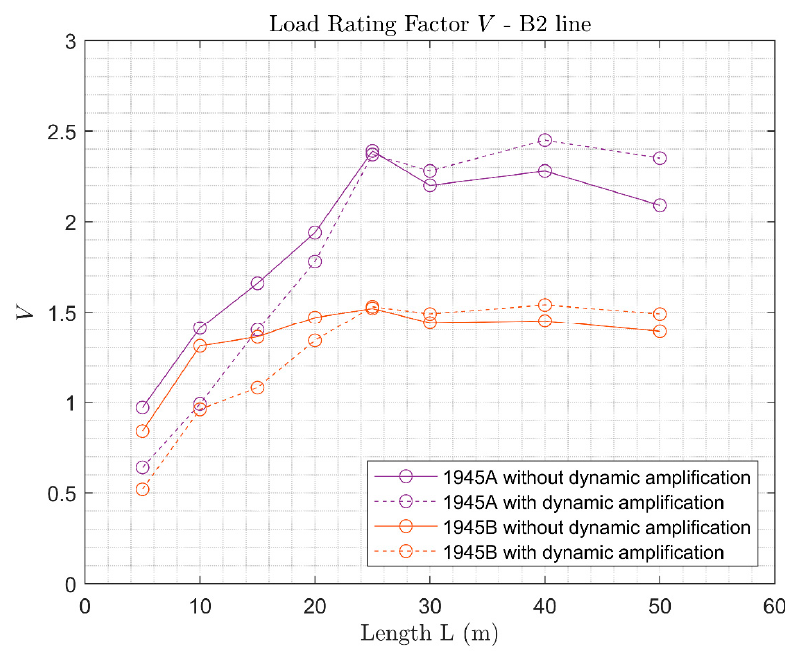
Figure 17. Load Rating Factor of arches designed according to the 1945 code and verified with B2 loads, both with and without dynamic amplification